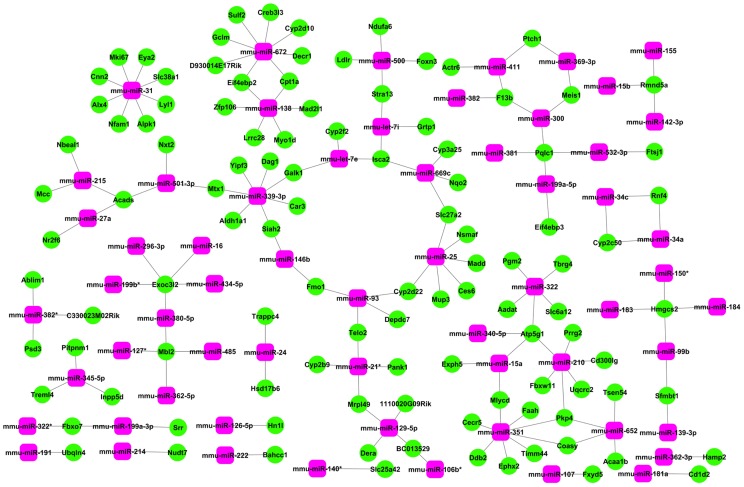
MiRNA-Gene-Network.Pink box nodes represent miRNAs, and green cycle nodes represent the predicted target genes. Edges show the inhibitory effect of miRNA to its predicted targets. Two overexpressed miRNAs (mmu-miR-351 and mmu-miR-672) show the most target mRNAs of 8 (degree 8). In contrast, mmu-miR-31 has the highest degree in those under-expressed miRNAs. Degree means the contribution one miRNA to the genes around or the contribution one gene to the miRNAs around. The key miRNAs and genes in the network always have the highest degrees.